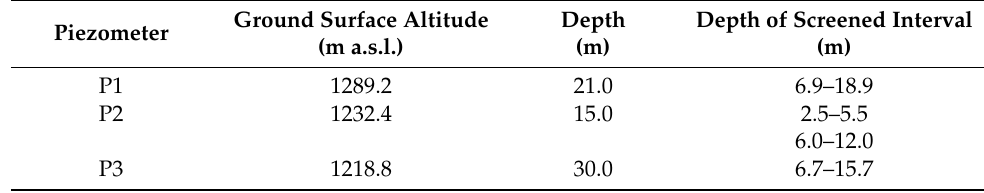
Table 1. Basic data for